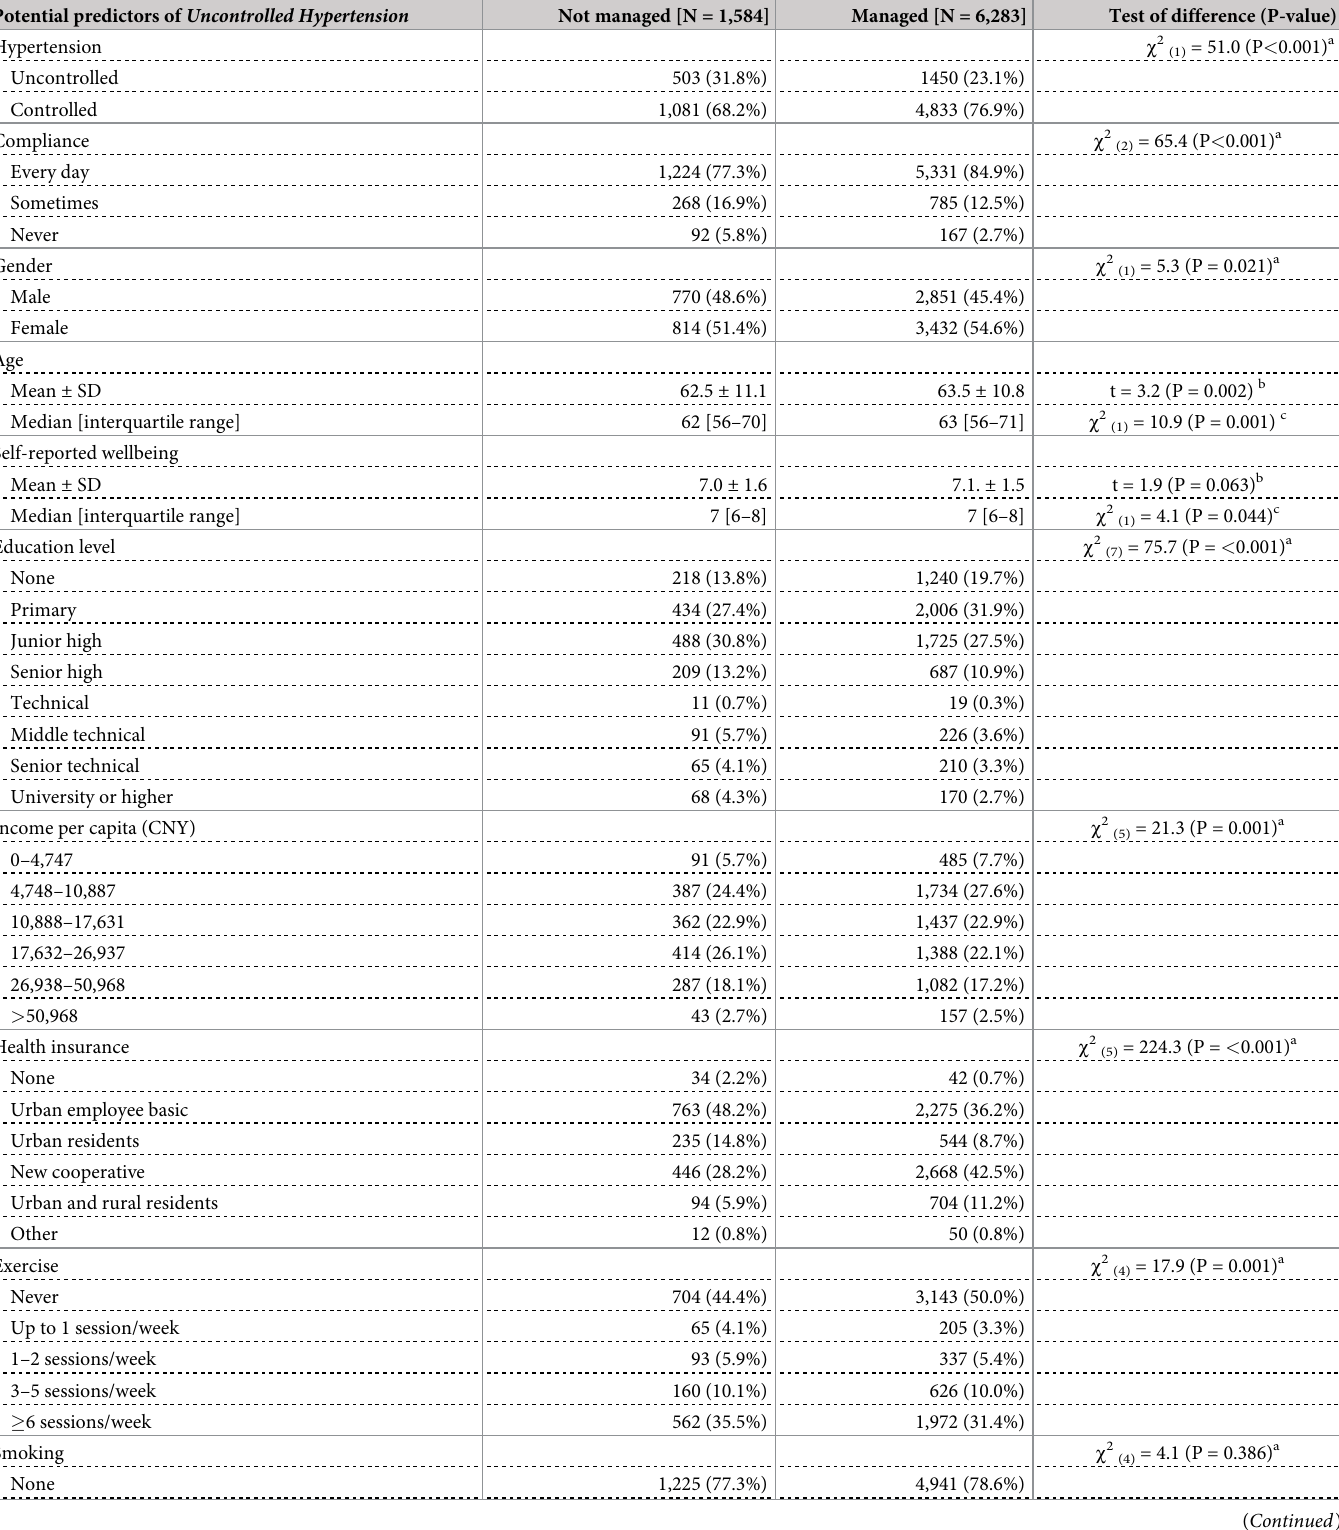
Table 3. Breakdown of demographic characteristics in the study cohort by management